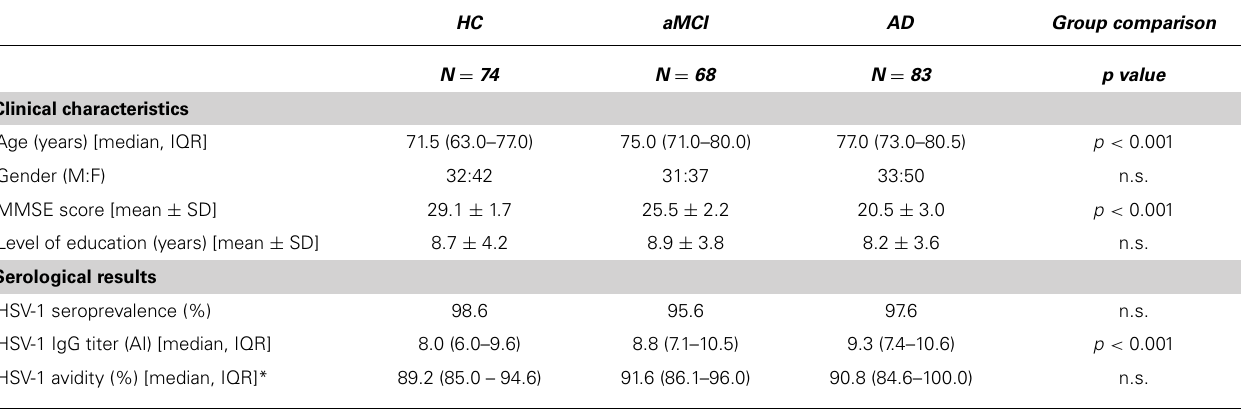
Table 1 | Clinical characteristics and serological results of studied